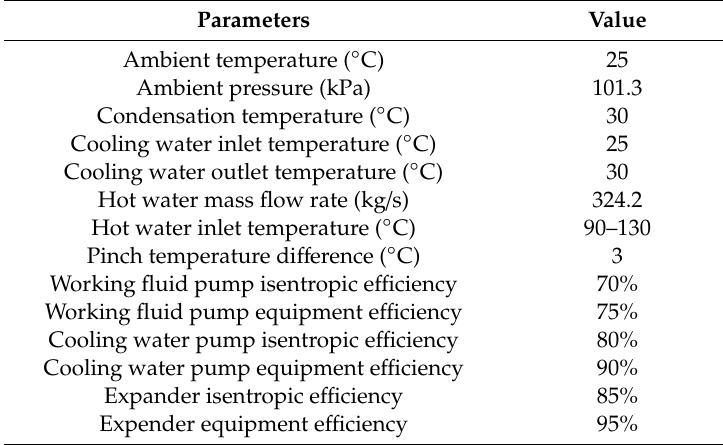
Table 1. Simulation parameters and boundary conditions used in this